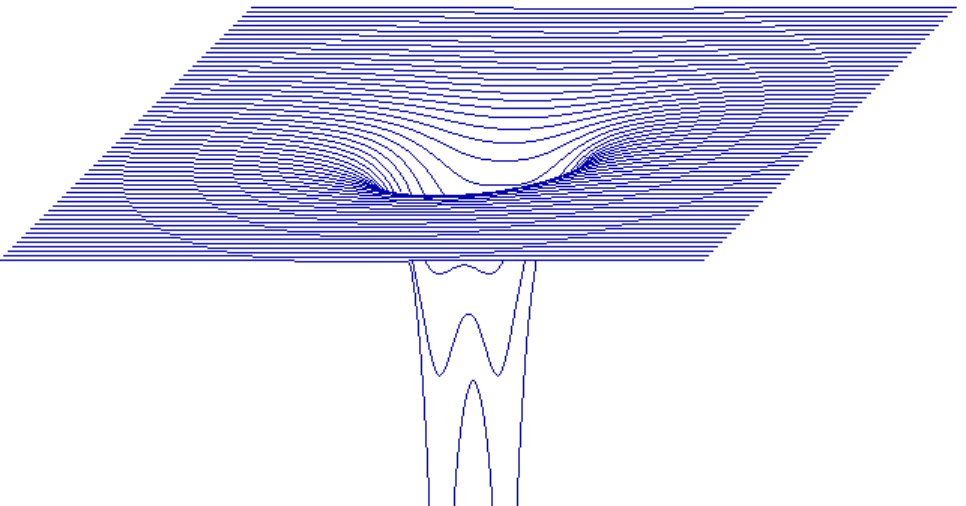
Figure 1. Schematic illustration of the gravitational potential of a binary black hole merger. By ([4], p.3) the highest amplitude of the detected gravitational waves was reached for the separation R = 3